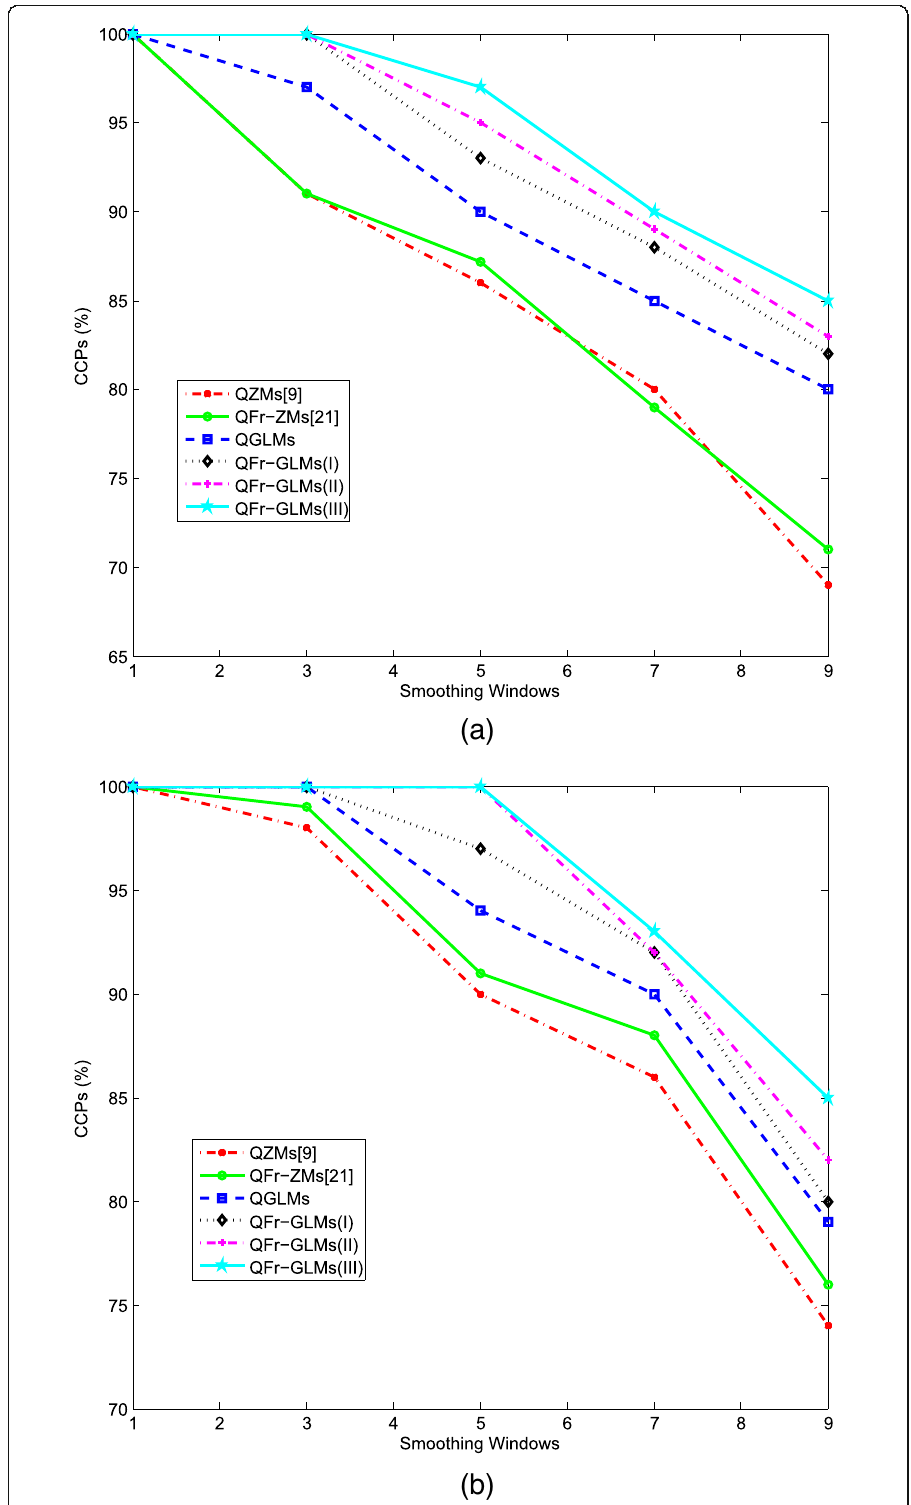
Fig. 13 Classification results of the Buttery color image dataset: a low-order moment ( k = 12) and b high- order moment ( k =